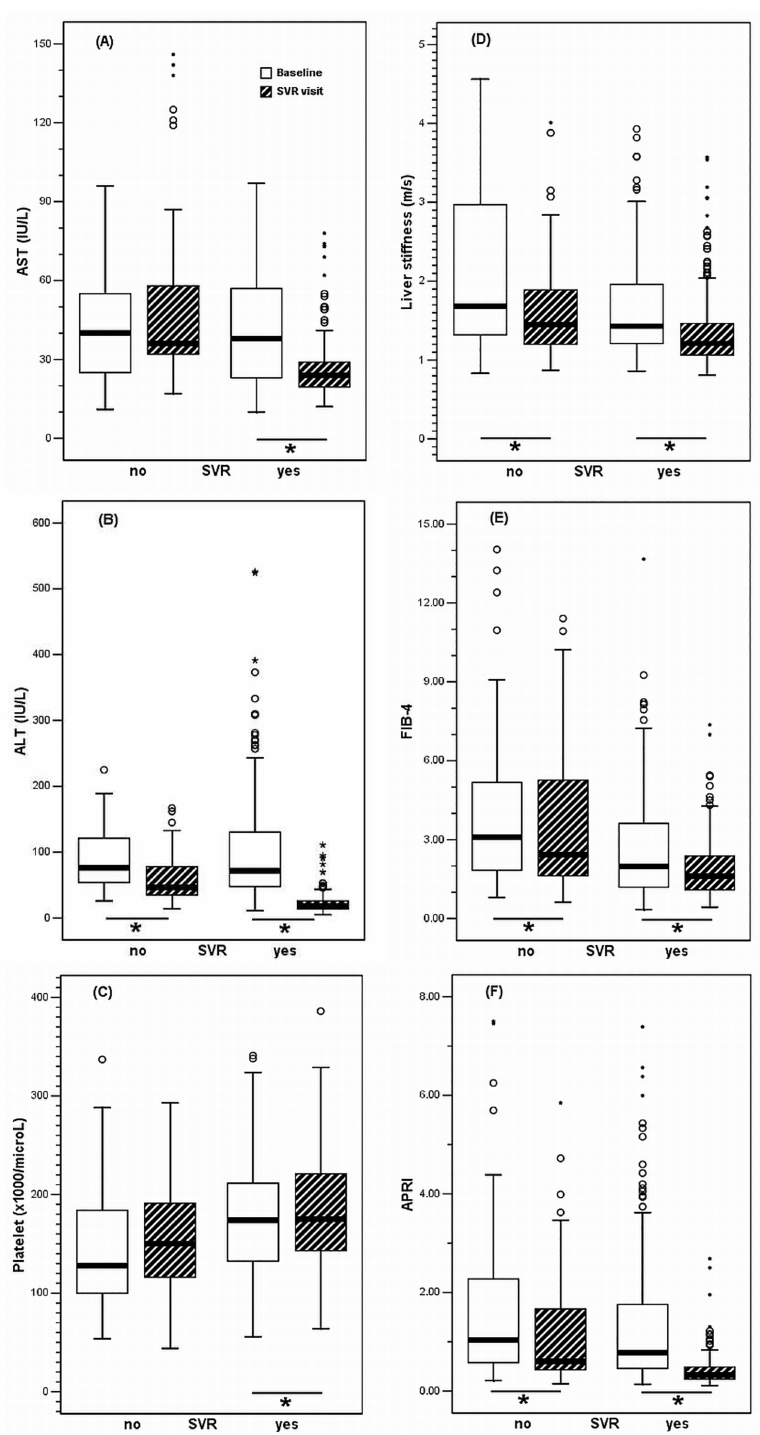
Fig 1. The paired values of aspartate aminotransferase (AST), alanine aminotransferase (ALT), platelet, liver stiffness, fibrosis-4 (FIB-4) index, and aspartate aminotransferase-to-platelet ratio index (APRI) compared between baseline and sustained virologic response (SVR) visit. SVR status: yes, n = 219; no, n = 37; (cid:3) P < 0.05.